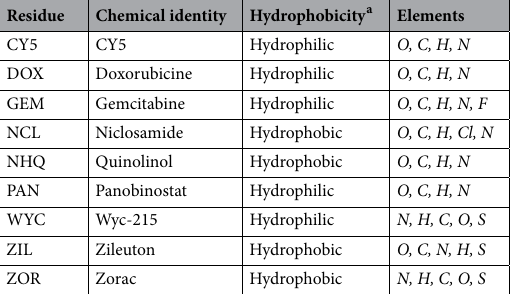
a This property is not absolute; hence, it is determined